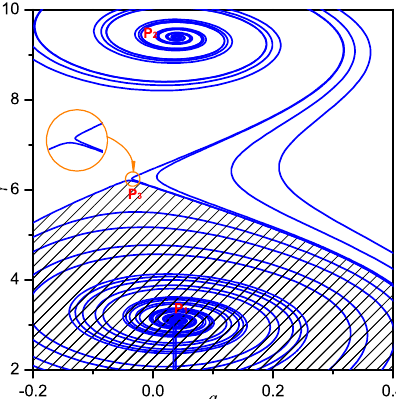
Figure 5. State plane for the response of the nonlinear beam ( σ = 0.25, p = − 0.05, f = 0.02, µ = 0.02).